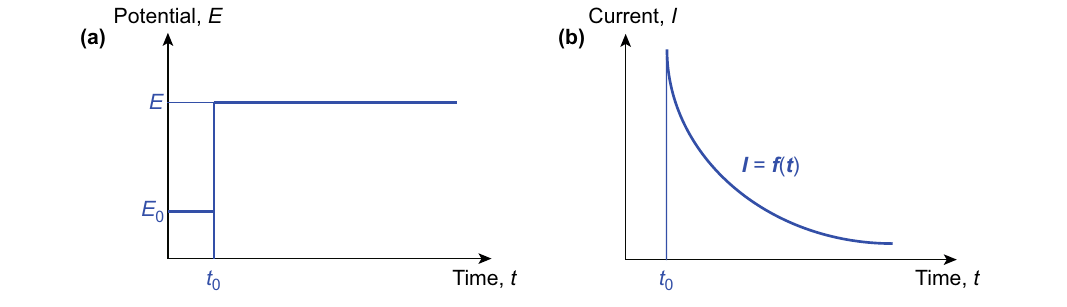
Fig. 3 a Constant potential applied in potentiostatic deposition; E 0 and E are the open‑circuit potential and the applied potential; t 0 marks the starting time of deposition. b Corresponding current as a function of